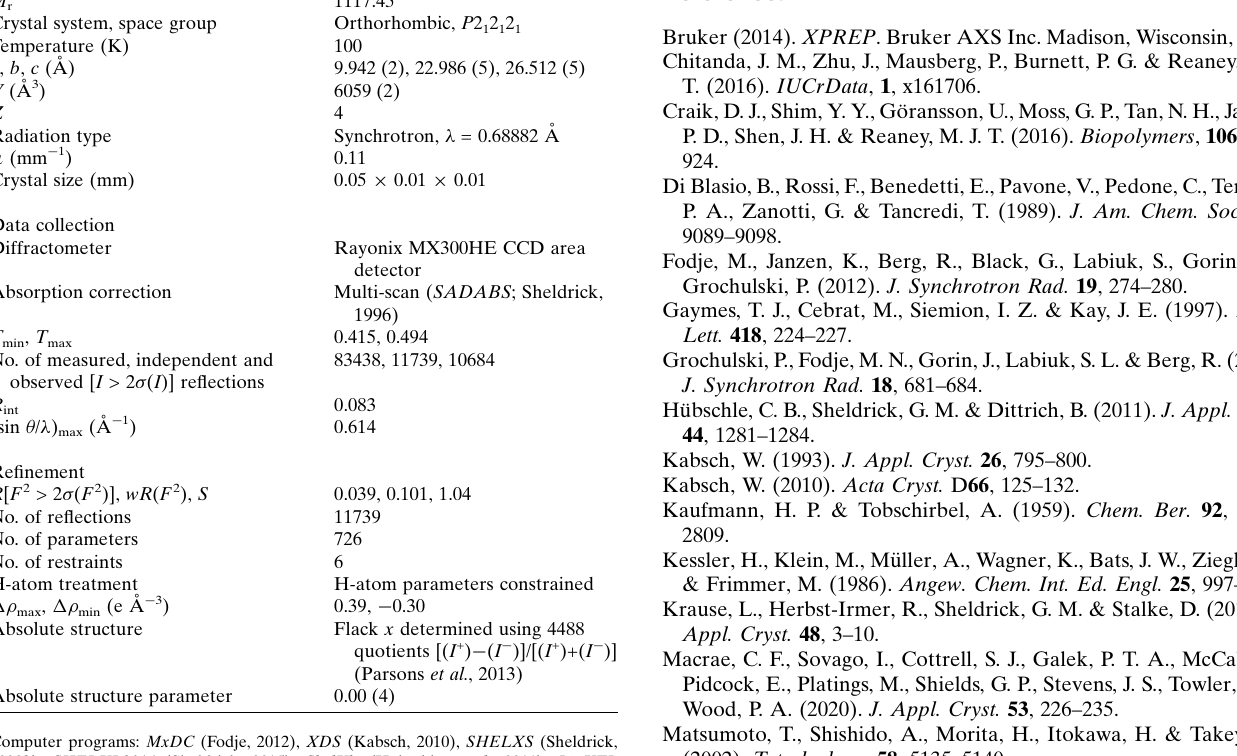
Table 2 Experimental details. Crystal data Chemical